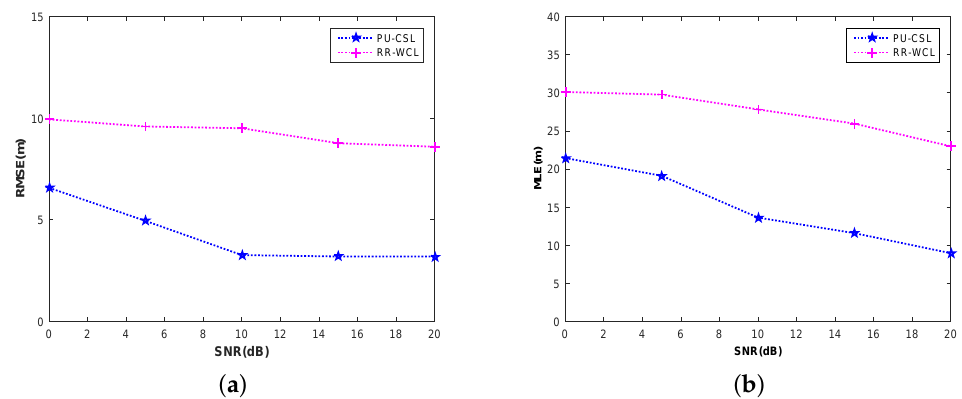
Figure 5. The localization performance of the PU-CSL and RR-WCL algorithms. ( a ) The root mean square error with the signal-to-noise ratio curve; ( b ) The maximum location error with the signal-to-noise ratio curve.